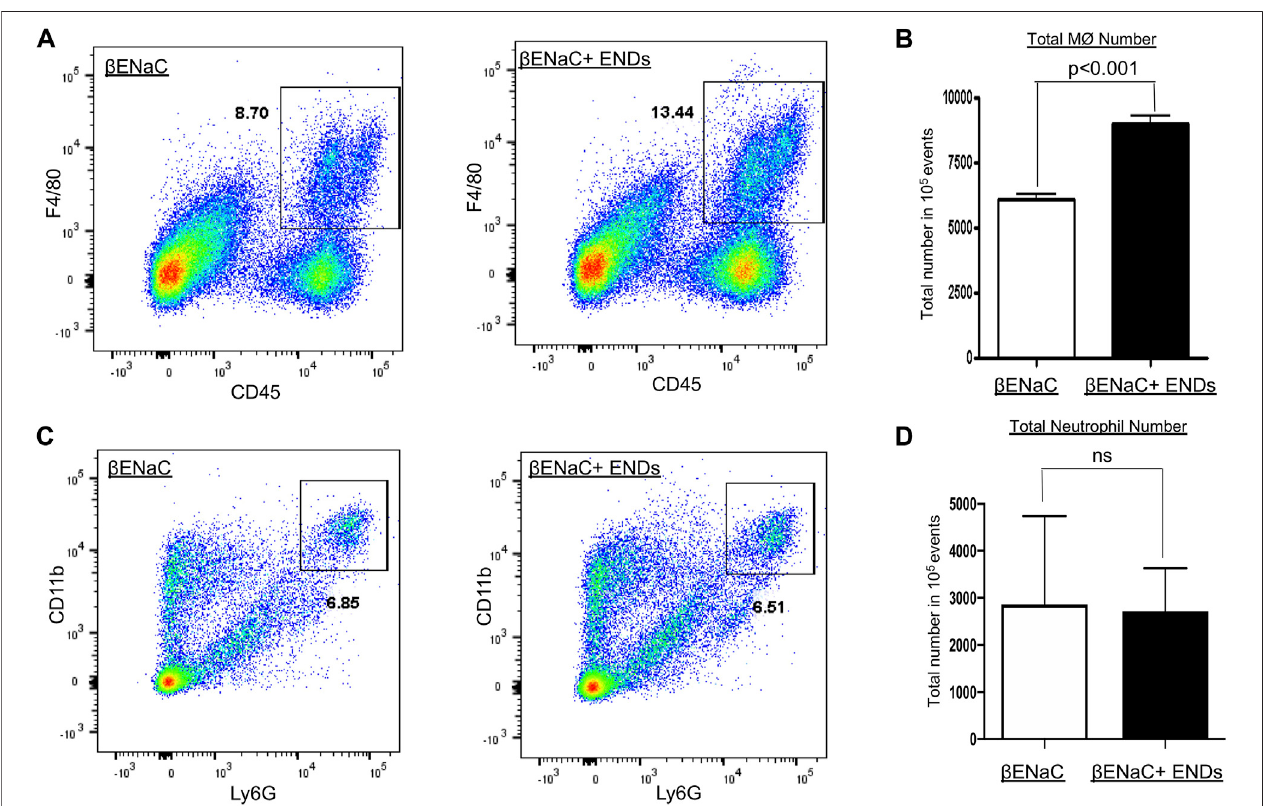
FIGURE 3 | E-cigarette increases macrophage numbers in lungs. (A,C) FACS analysis of cell population of CD45 + F4/80 + macrophages and CD11b + Ly6G + neutrophils in lung tissues of β ENaC mice with or without ENDS exposure ( n (cid:1) 3 per group). (B,D) Quanti fi cation of FCAS analysis of macrophage and neutrophil population as in (A) and (C) , respectively. All data presented at mean ±